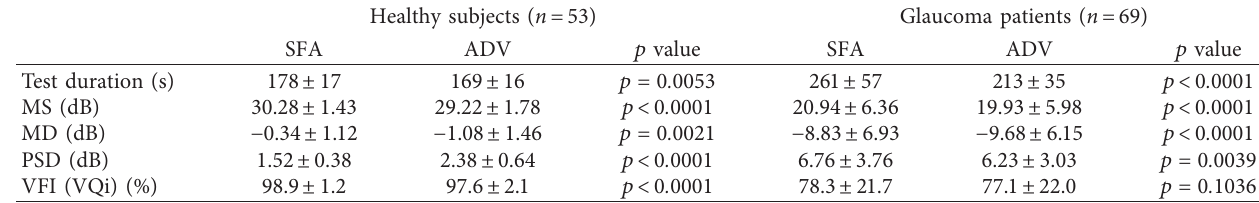
Table 1: Visual field indices values for the SFA and ADV strategies in healthy and glaucomatous eyes.